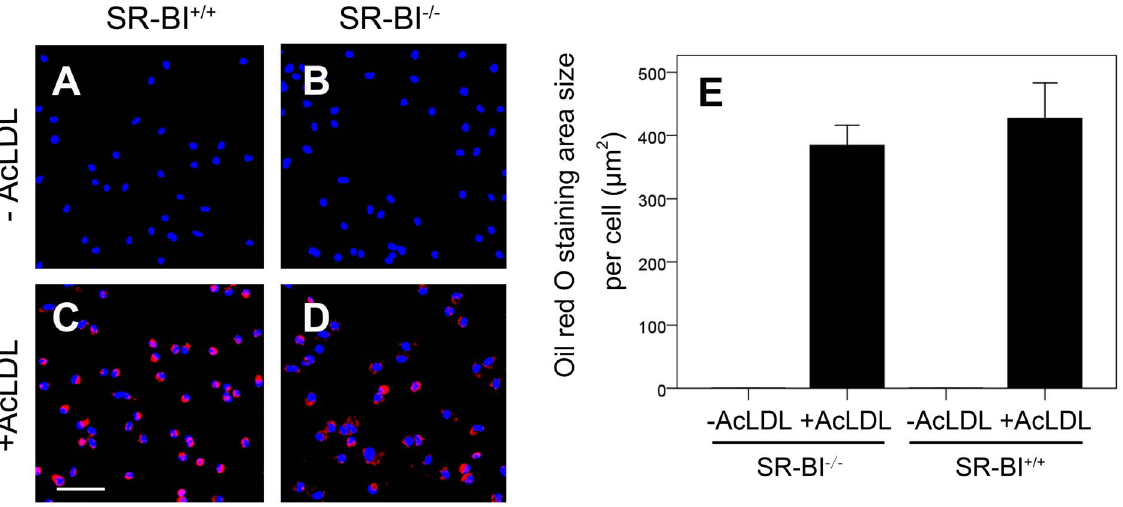
Figure 5. Knockout of SR-BI in macrophages does not affect AcLDL driven foam cell formation . Resident peritoneal macrophages collected from SR-BI + / + apoE-hypomorphic or SR-BI 2 / 2 apoE-hypomorphic mice were cultured in the absence or presence of 100 m g/ml AcLDL for 24 hrs, fixed and stained with oil red O (red) and DAPI (blue). A – D : Representative fluorescence images. Scale bar = 100 m m. E . Quantification of lipid accumulation as the oil red O staining intensity normalized to the number of DAPI stained nuclei per field of view. Five fields of view were analyzed per sample. Data are averages 6 standard errors of triplicate samples. The experiment was performed three times and a representative result is shown. Oil red O staining intensities for AcLDL treated versus untreated cells were statistically significantly different but staining intensities for AcLDL treated SR-BI + / + and SR-BI 2 / 2 cells were not (determined by Student’s T test).